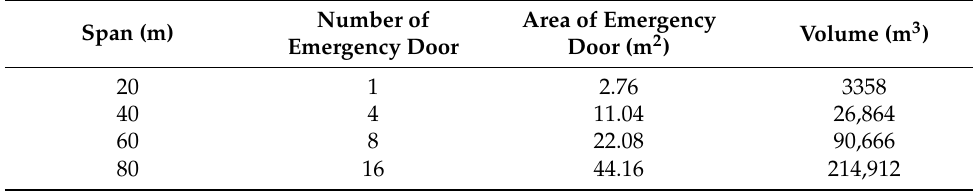
Table 3. Leakage area and volume of different air-supported structures.